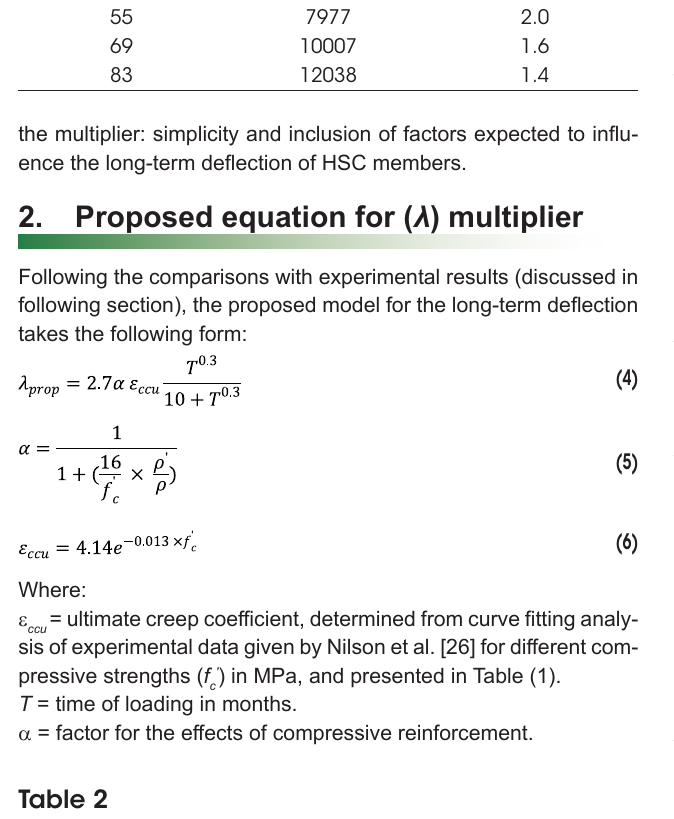
' Creep coefficient, c